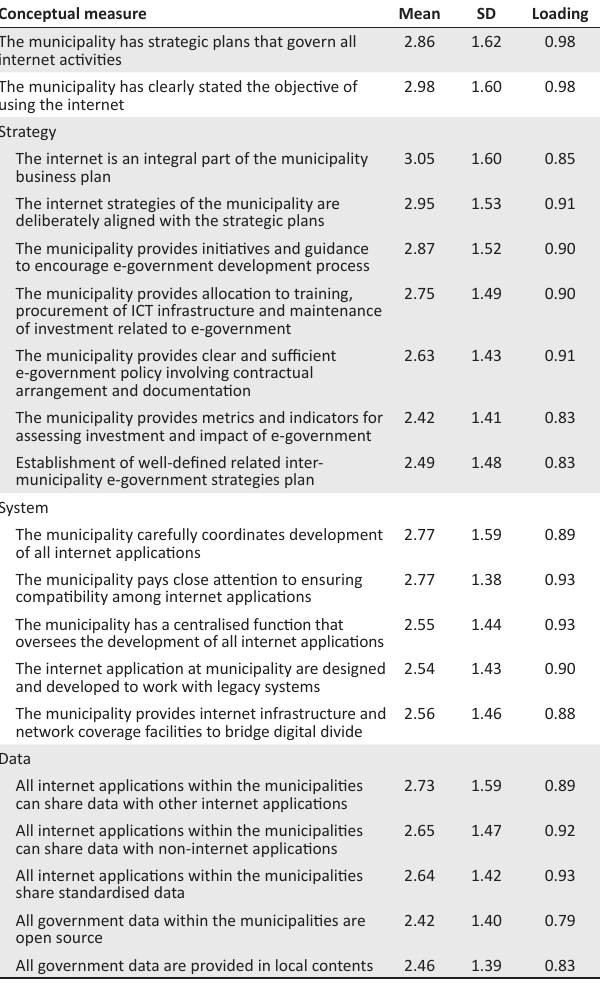
TABLE 5: Confirmatory factor analysis of municipal government readiness.